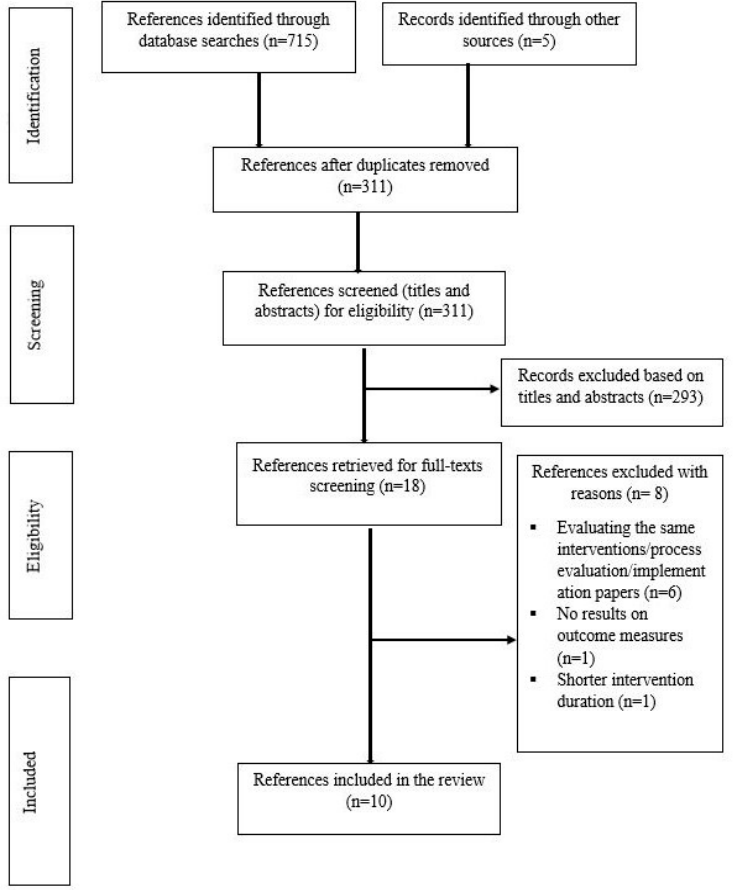
Figure 1. Flow chart for the literature search for intervention studies.